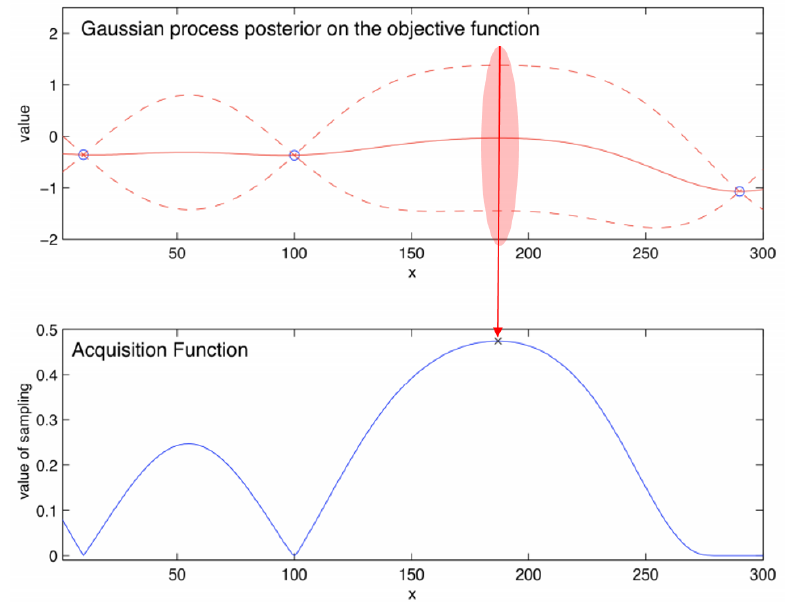
Figure 1. Illustration of Bayesian Optimization, maximizing an objective function f with a one-dimensional continuous input